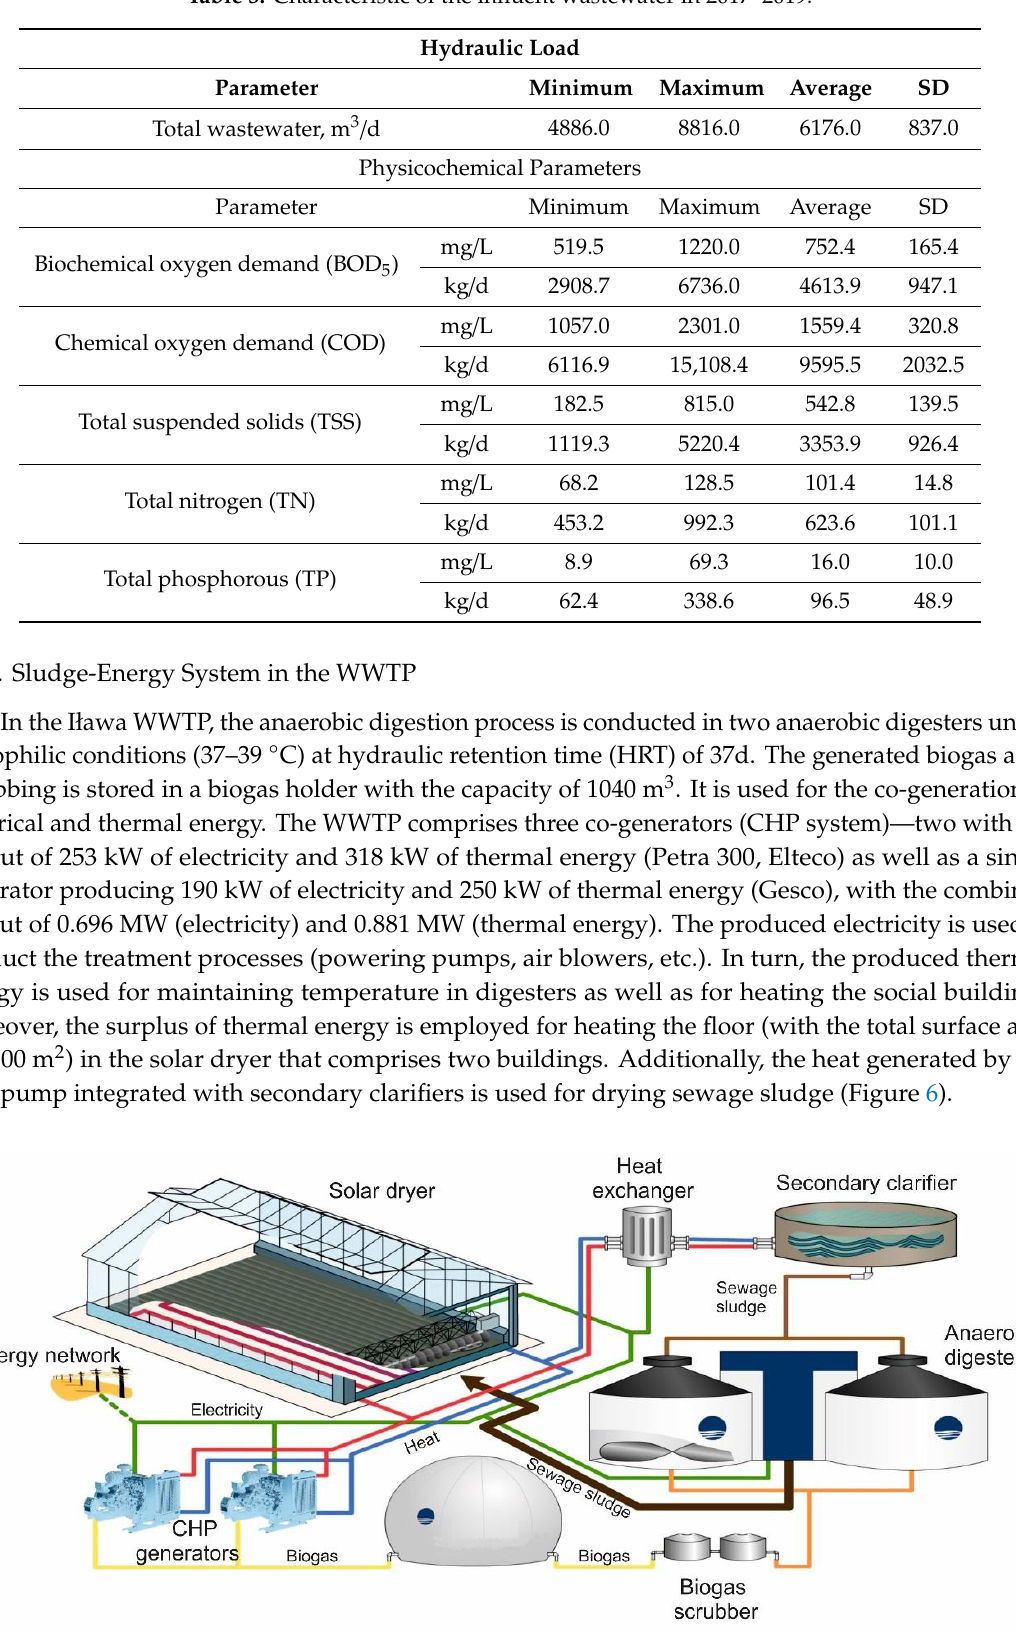
Figure 6. Scheme of energy usage in the WWTP i n Iława .